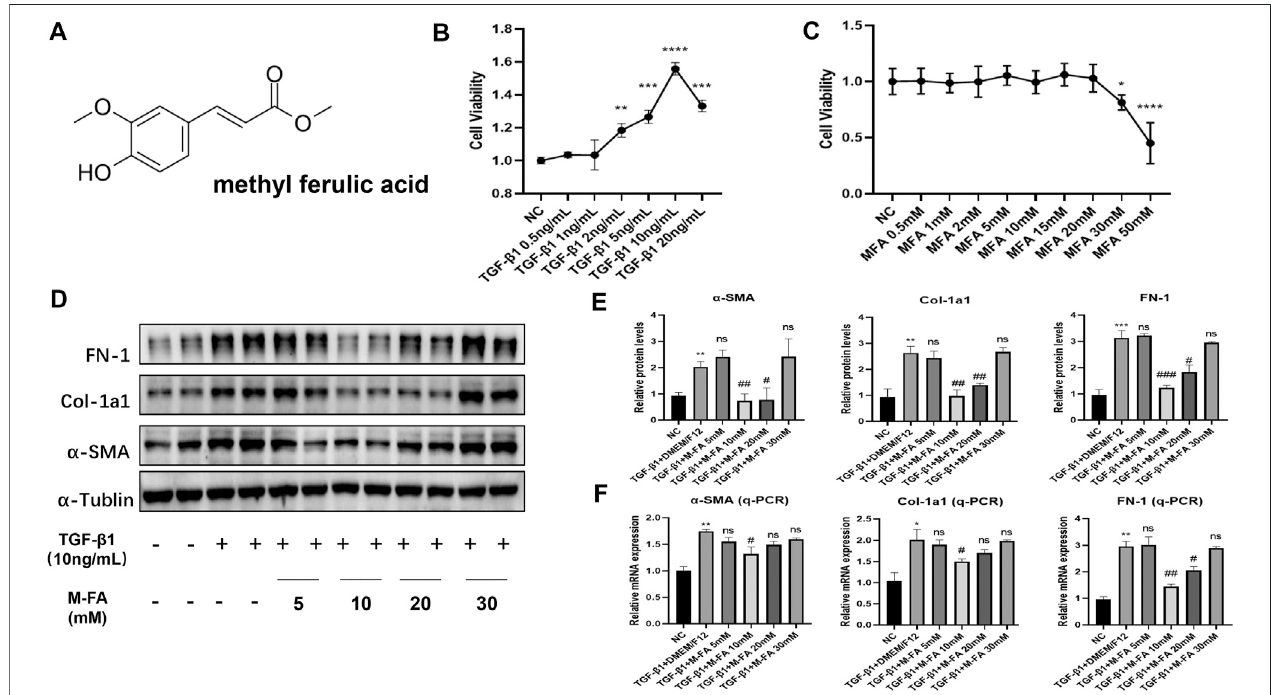
FIGURE 1 | MFA reduced fibrosis-related genes expression in TGF- β 1 – stimulated HCFs. (A) Chemical structural formula of MFA. (B – C) Cell viabilities when HCFs were treated by different concentrations of TGF- β 1 (B) and MFA (C) ( n (cid:2) 6). (D – F) Protein (D. E) and mRNA (F) expression levels of fi brosis-related genes ( n (cid:2) 4). (*compared with negative control: * p < 0.05, ** p < 0.01, *** p < 0.005, **** p < 0.001. # Compared with the TGF- β 1 group: # p < 0.05, ## p < 0.01, ### p < 0.005).